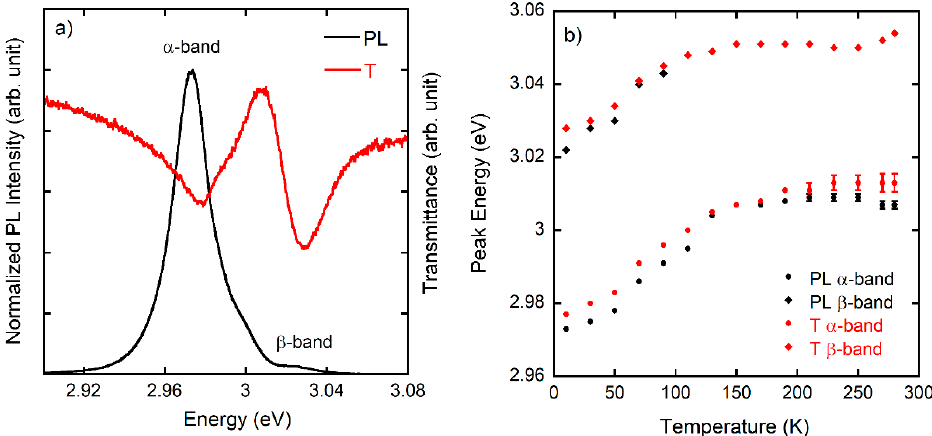
Figure 3. ( a ) Macro-PL (black curve) and transmittance (red curve) spectrum on sample A at 10 K after excitation at 4.67 eV. ( b ) Emission energy of the maximum of the PL for the α and β -band along with the corresponding minima of the transmittance spectra as a function of temperature for sample A.